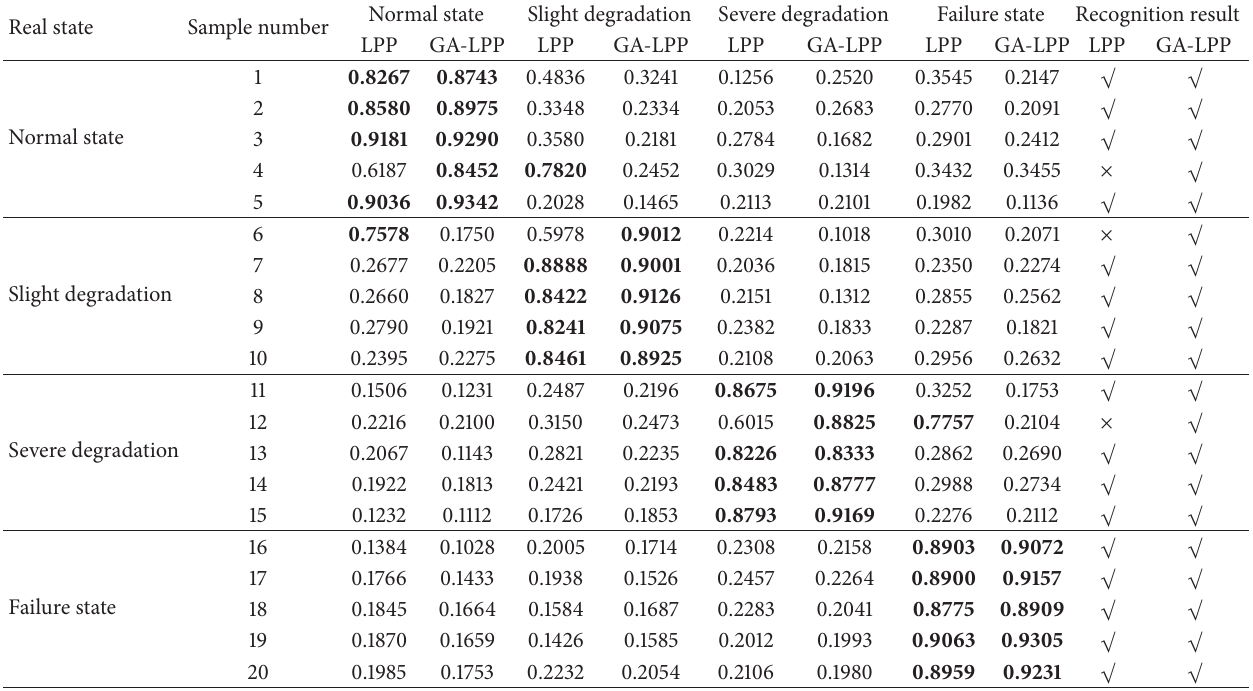
Table 3: Result of the rolling bearing degradation state identification.